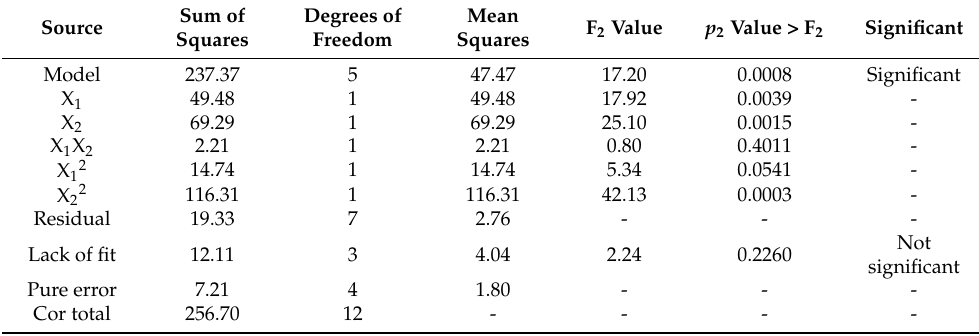
Table 6. Variance analysis results of the quadratic regression model of Y 2 .